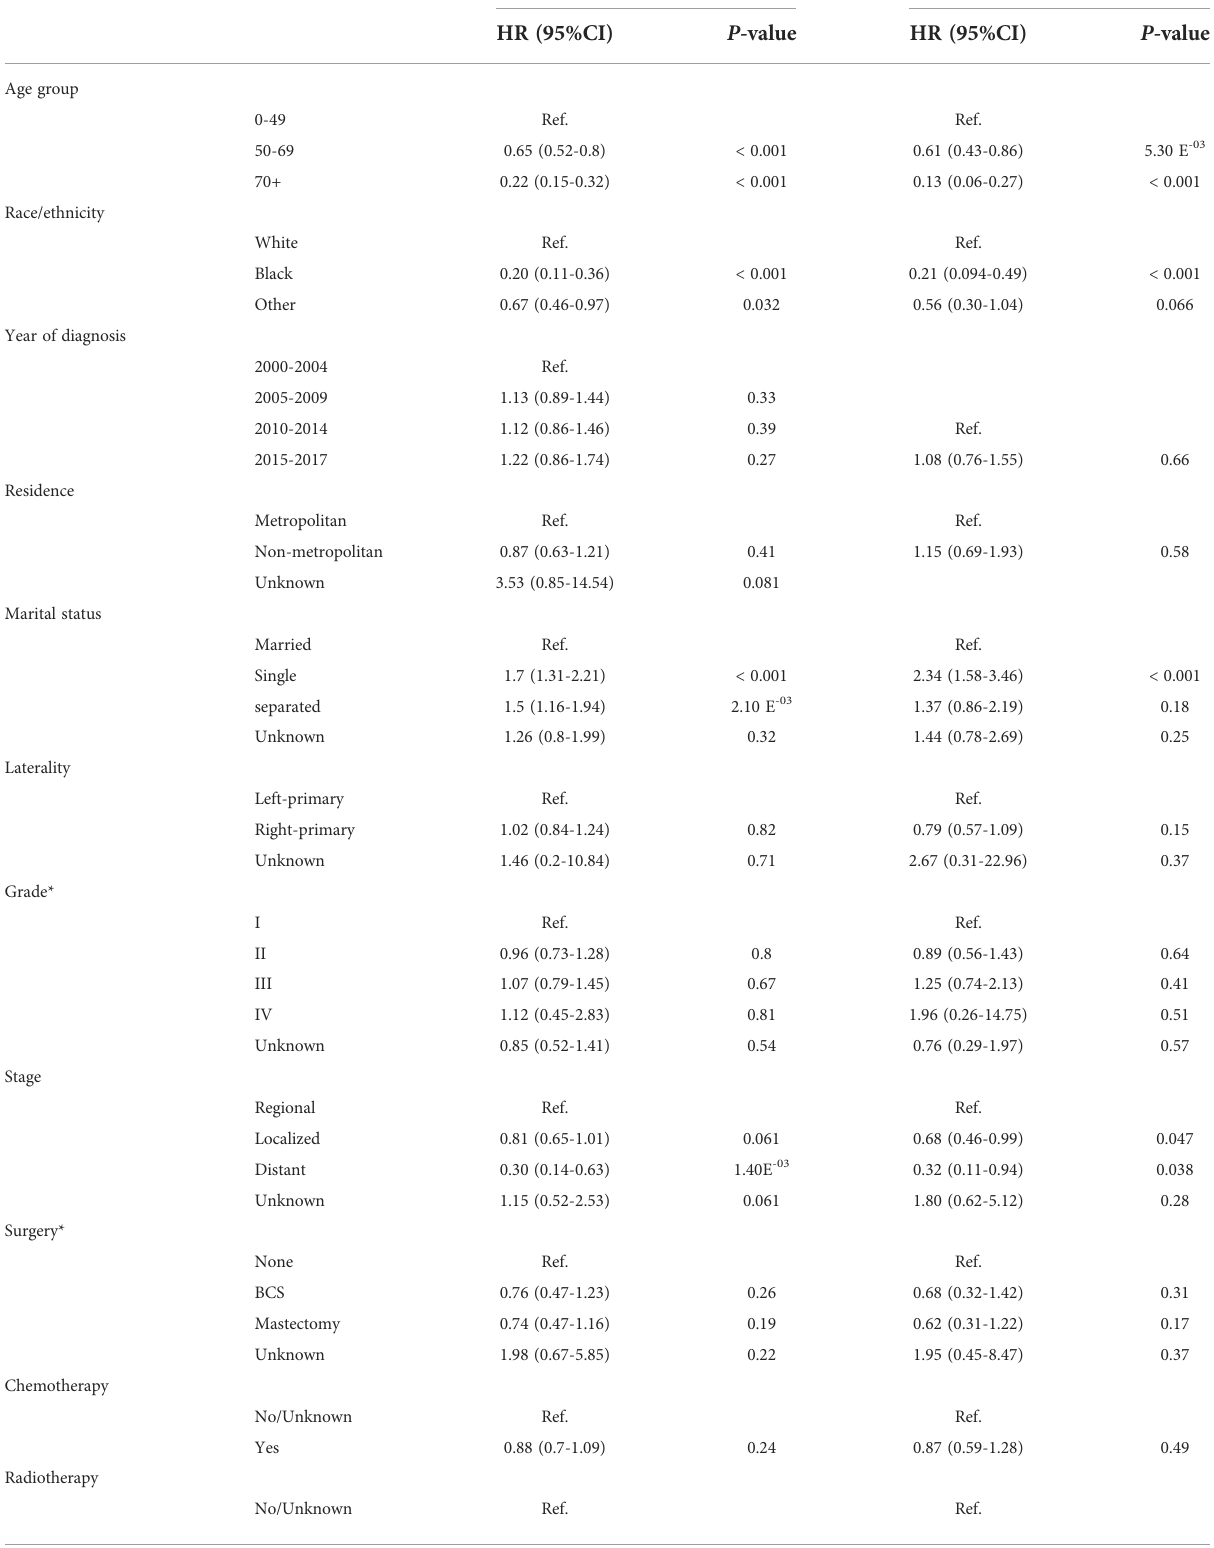
TABLE 4 Adjusted hazard risk of suicide among female breast cancer survivors assessed by the Fine and Gray